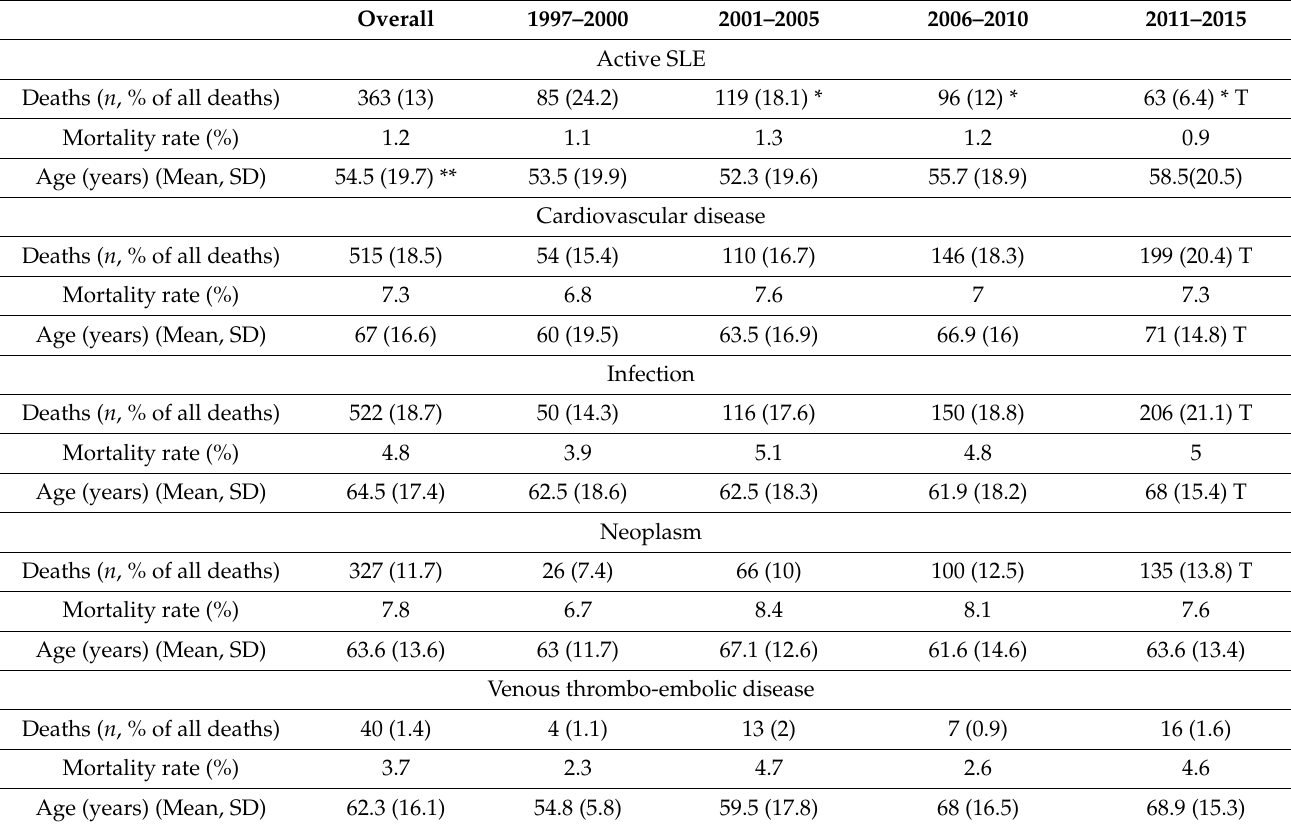
Table 3. Causes of mortality during admission and mean age of SLE